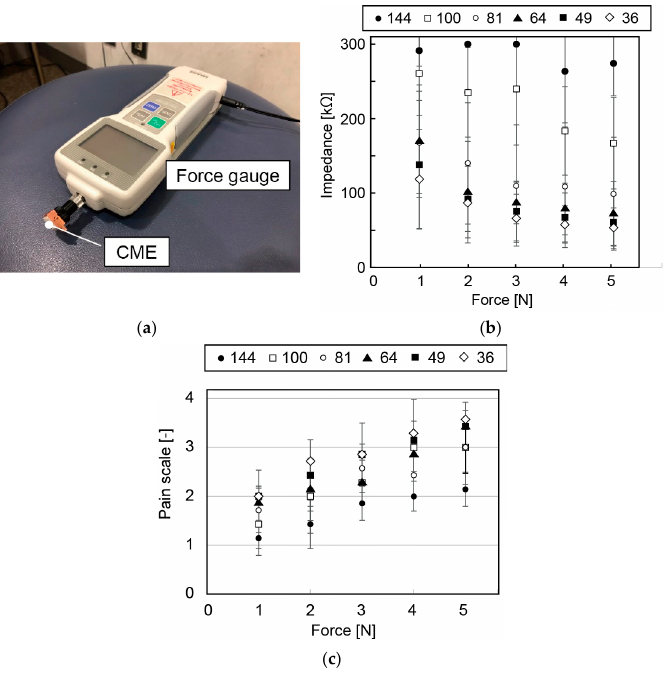
Figure 4. ( a ) Photograph of CME connected to force gauge. When the CME is pressed to the parietal part, the skin-to-electrode impedance is measured while the applied pressure is monitored by the force gauge. The participants recorded their perceived pain using a visual analogue scale. ( b ) Measured impedance with respect to applied force for various types of CME (summarized in Table 1).